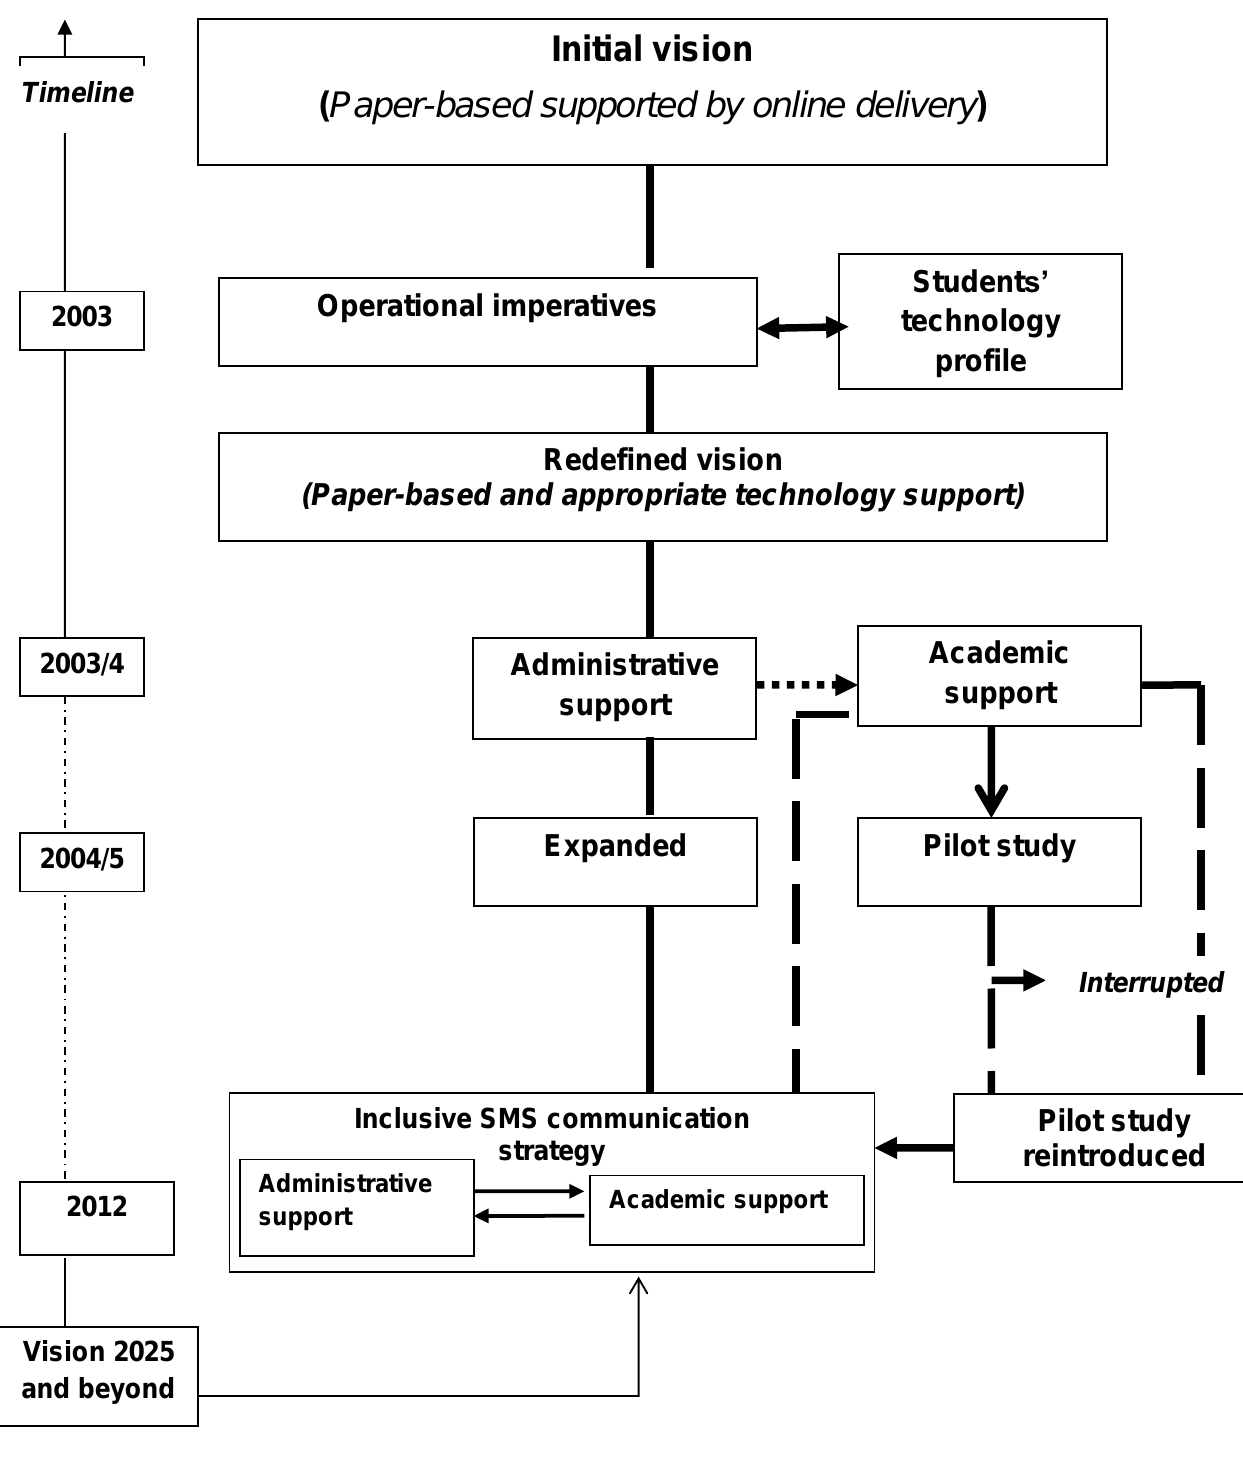
Figure 2. Development of the use of SMS for distance education students at the University of Pretoria. Adapted from Educational technology changes in Africa and its impact on ODL programmes delivery: the case of the University of Pretoria, South Africa, (page 10) by J. Hendrikz and F. R. Aluko, 2013. Copyright by ICDE 2013 World Conference. Adapted with